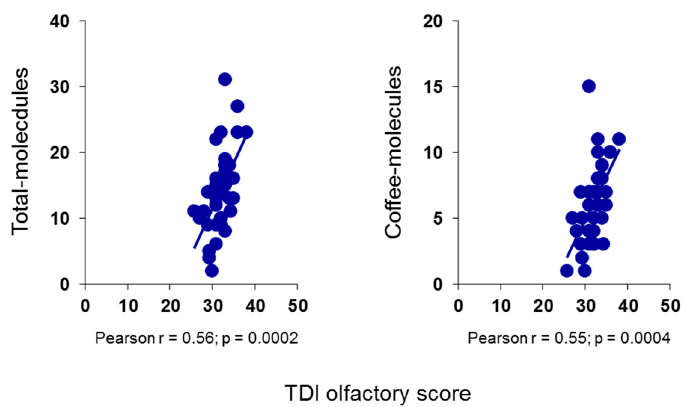
Figure 2. Correlation analysis between the number of total- and coffee-molecules smelled by each subject and his/her TDI olfactory score.